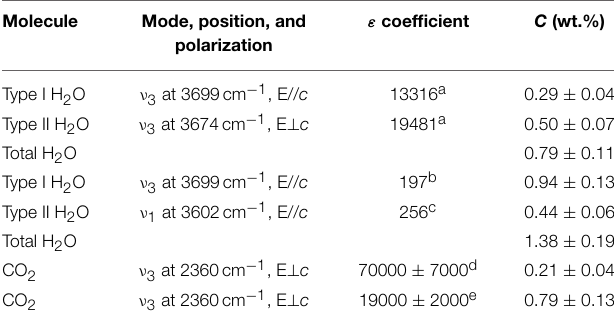
AA (cid:6) trace indicated in Figure 5A . Single-spot SR-FTIR analyses were collected with a beam size of 15 × 15 μ m and absorbance data were obtained by integrating the ν 3 mode at 3699 cm − 1